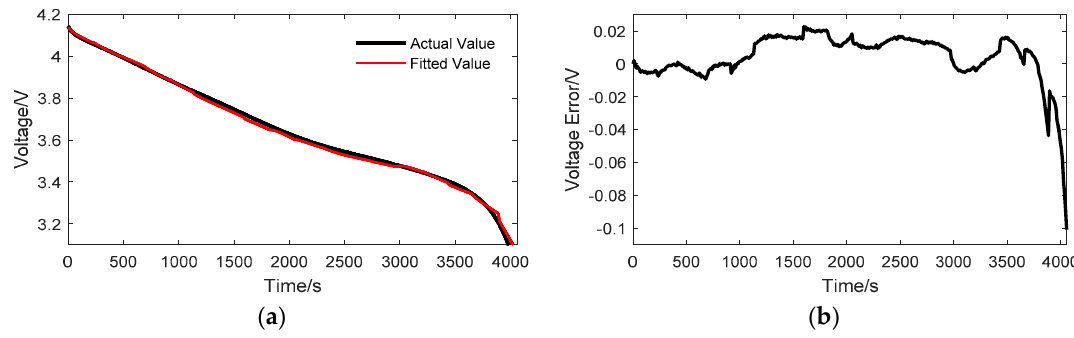
Figure 7. The 0.8 C constant current discharge profile: ( a ) the voltage; ( b ) the voltage error. Table 1. The identified model parameters.